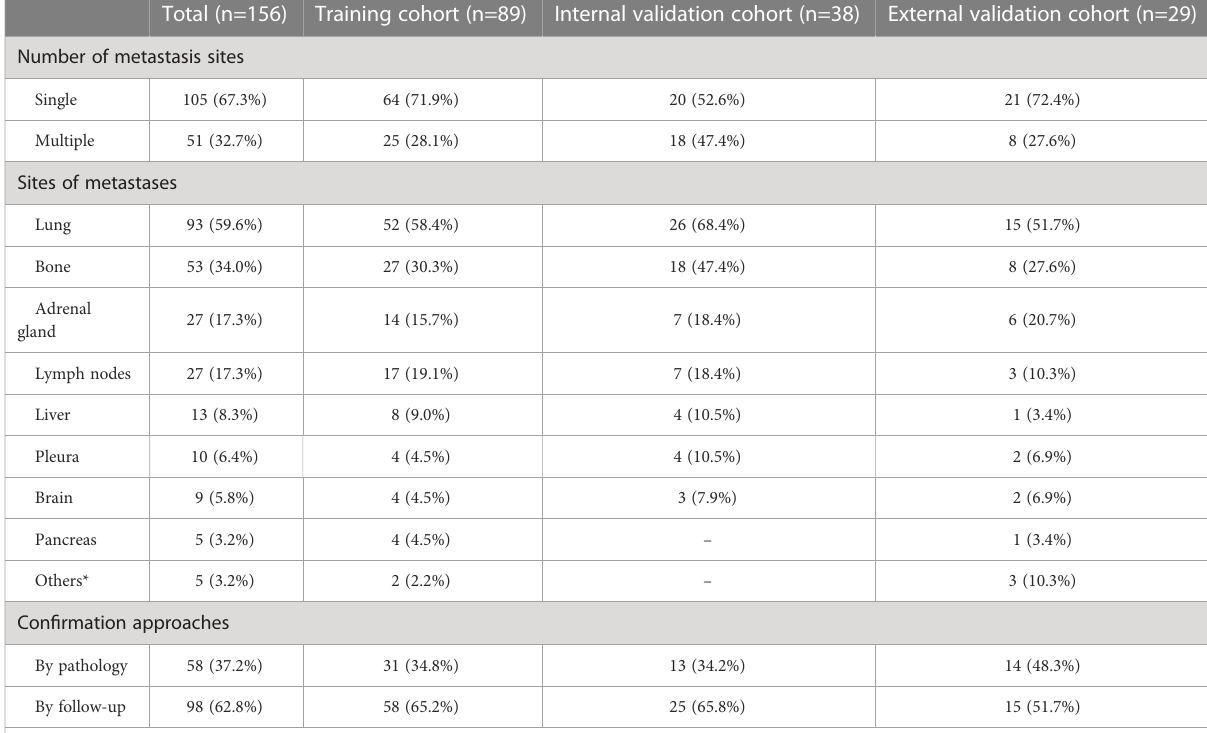
TABLE 2 Con fi rmation approaches of SDM and sites of metastases.